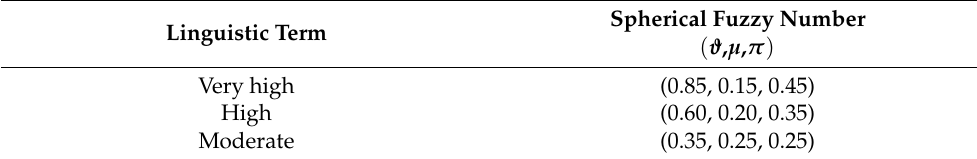
Table 2. Linguistic terms for expertise’s decision makers.